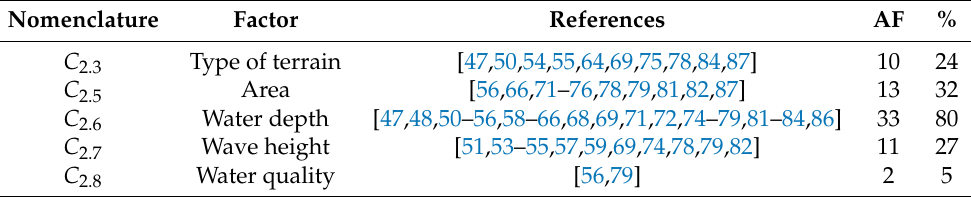
Table 14. Geographic Category ( C 2 )—Offshore wind energy. Quantitative analysis.